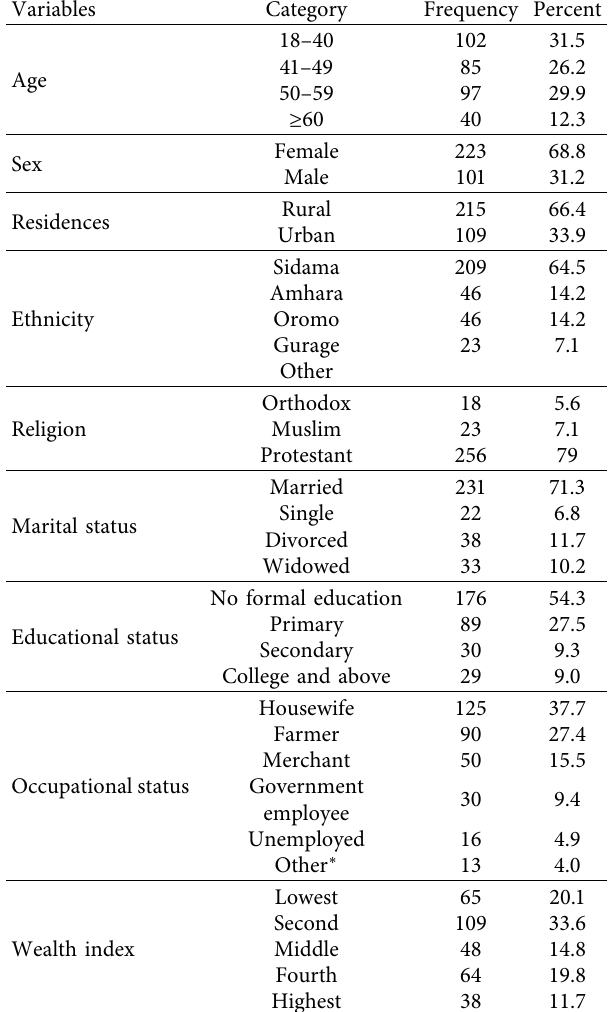
Table 1: Socio-demographic characteristics of adult cancer patients under chemotherapy treatment at HUCSH, Hawassa, Southern Ethiopia, 2021.